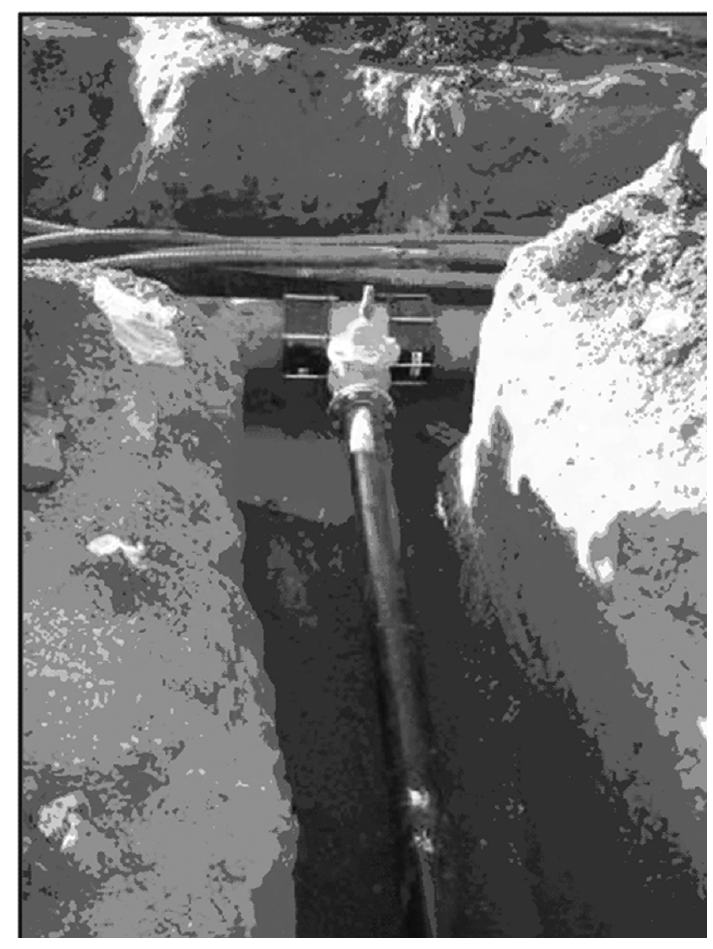
Figure 5: Installation of missing “T-Piece” in